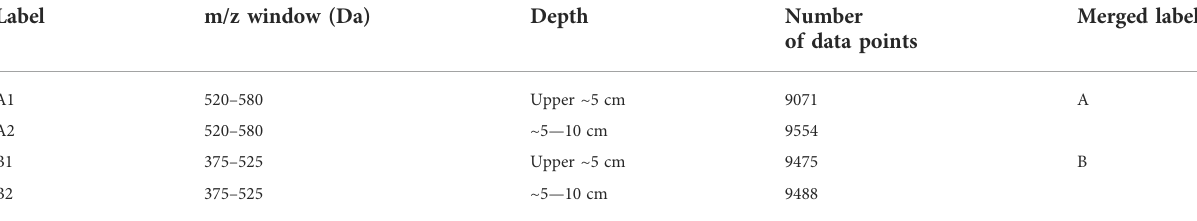
TABLE 1 Basic information of the MSI datasets employed in this